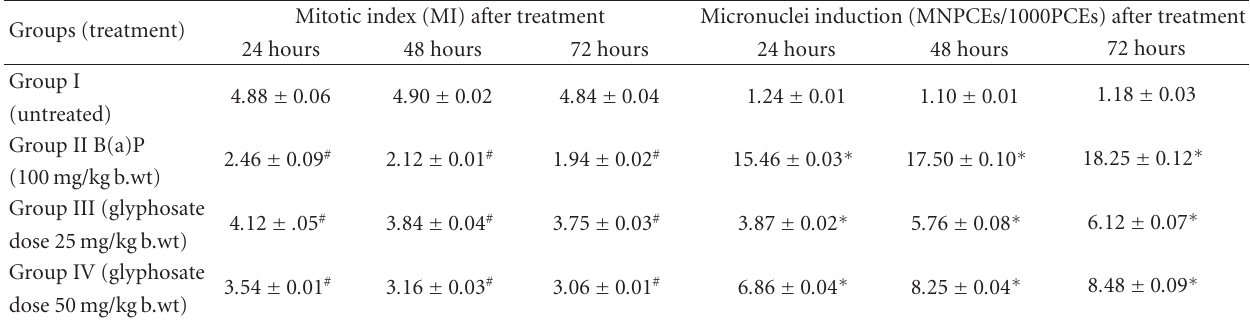
Table 2: E ff ects of glyphosate treatment on mitotic index and micronuclei induction in swiss albino mice. Groups (treatment)